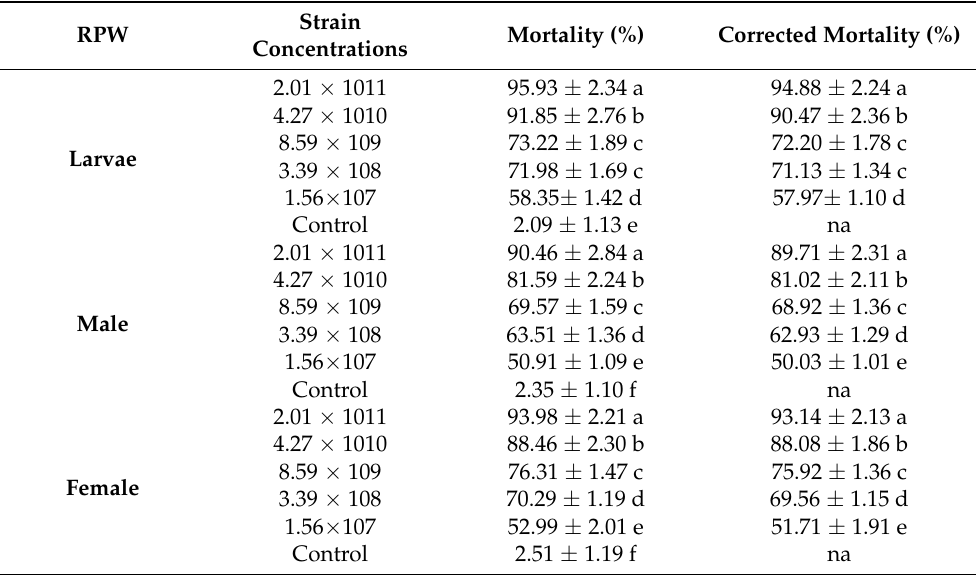
Table 3. The effects of Bacillus thuringiensis strain PDC-AHSAA1 concentrations on the mortality of RPW larvae and adults after 21 days of